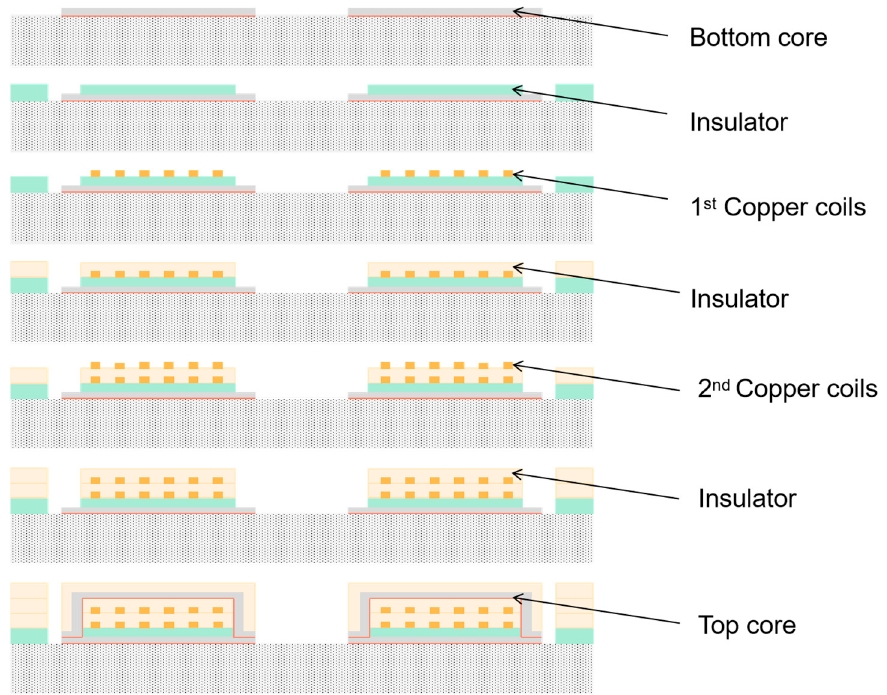
Figure 6. Double coil preparation process.